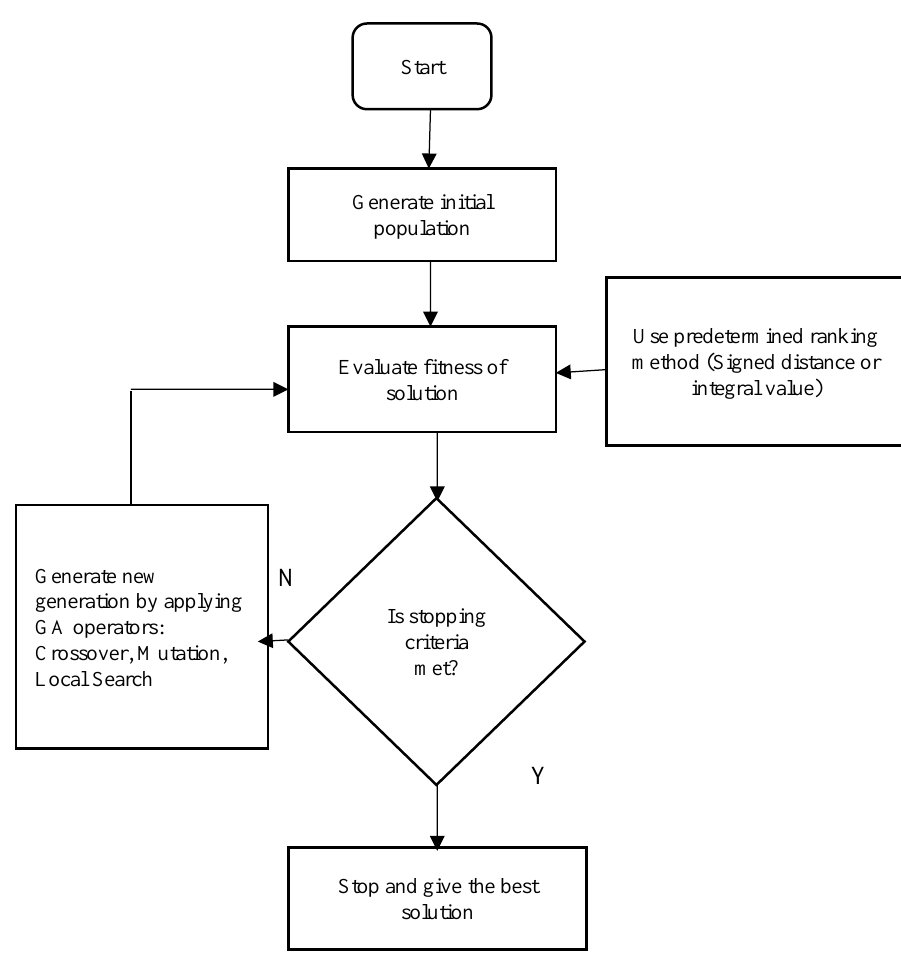
Figure A1 . Flow chart of the proposed GA methodology for fuzzy OAS problem